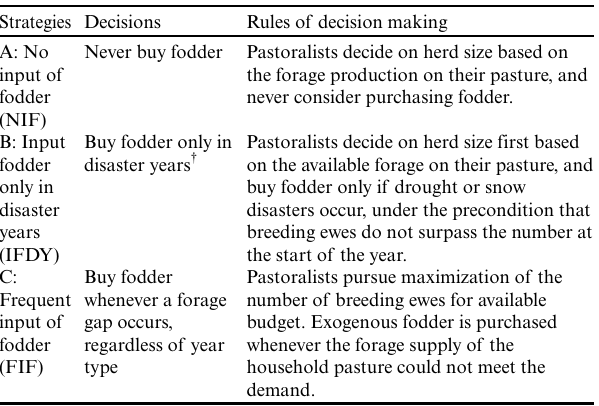
Table 1 . Three fodder strategies and the corresponding